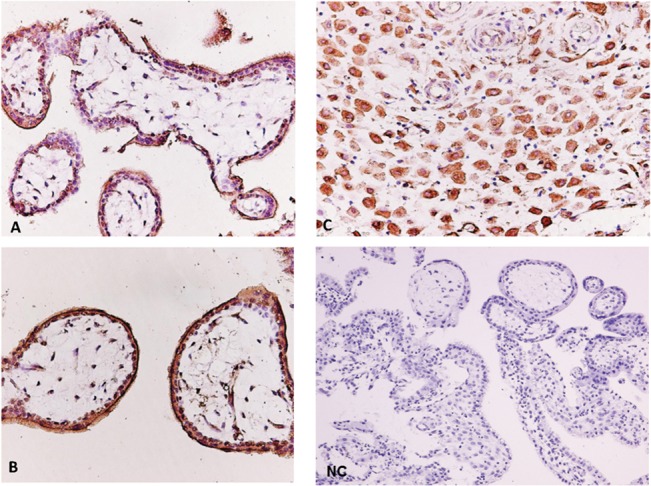
METRN immunohistochemisty in human placenta.Human placenta in the first trimester of pregnancy (spontaneous abortion) in which immature mesenchymal villi of first trimester decidua are illustrated. Moderate cytoplasmic immunoreactivity for METRN was observed in cytotrophoblast cells, syncytiotrophoblast cells and decidual cells (20x). A non-specific rabbit IgG was used as negative control in place of the primary polyclonal rabbit anti-METRN antibody in each immunohistochemistry placental specimen.